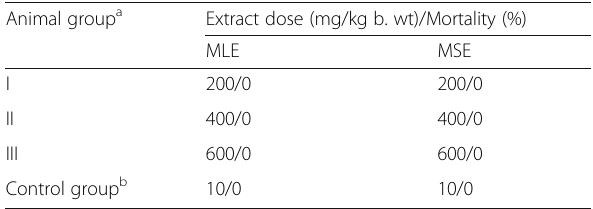
Table 5 Toxicity analysis of methanolic leaf and stem extracts of B. lupulina on albino rats